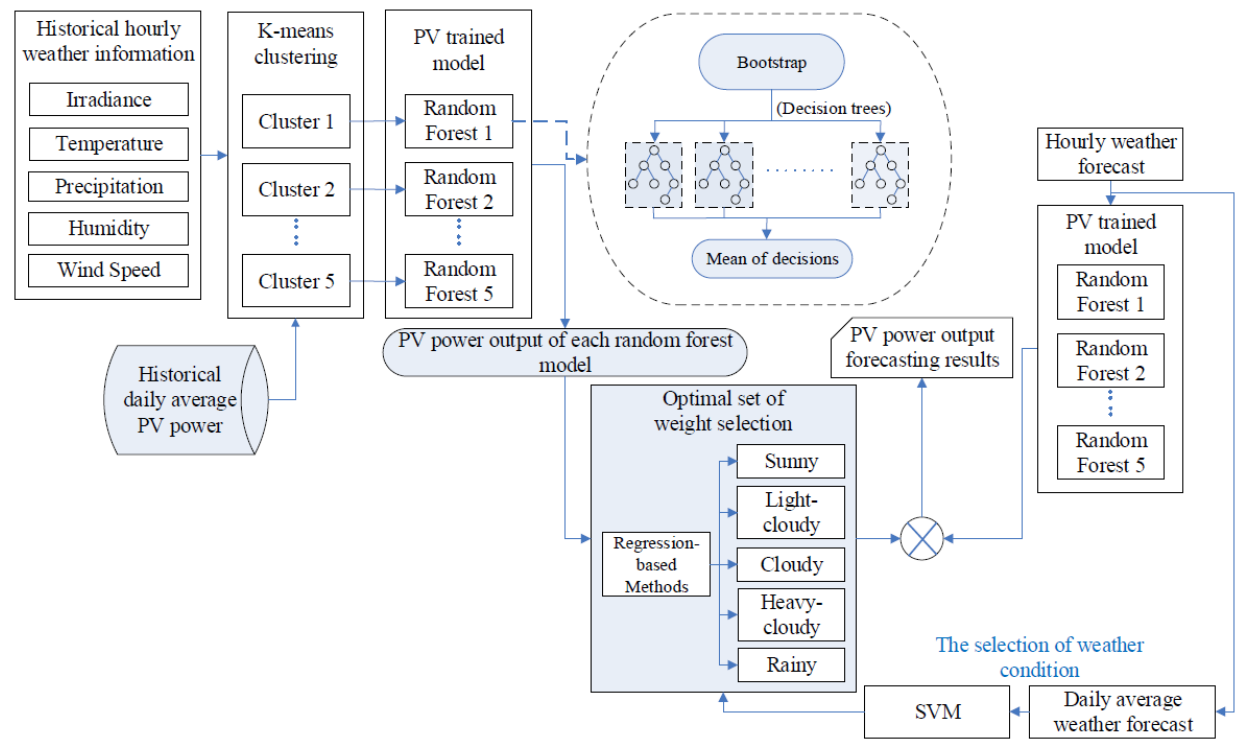
Figure 3. The general framework of a one-day ahead ensemble PV power forecasting strategy.